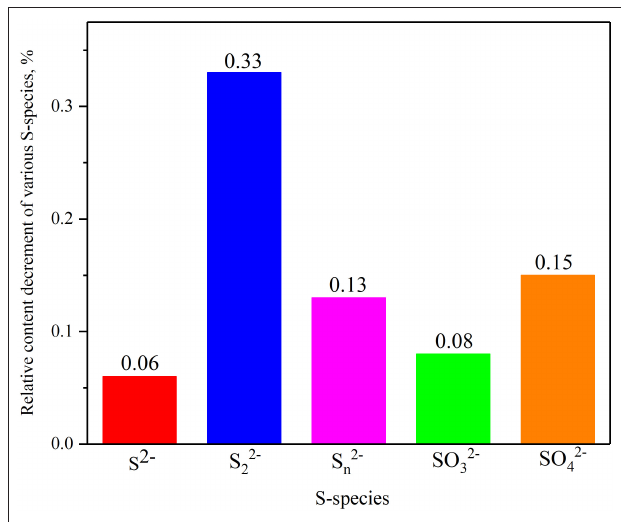
FIGURE 5 | Relative content decrement of various S-species in smithsonite samples from sulfidization for